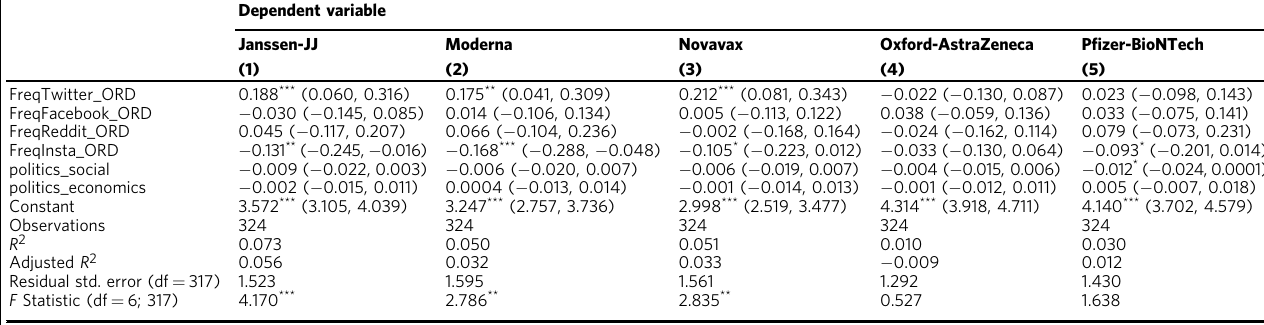
Table 3 Regressions for willingness to take each vaccine (excluding fi ctive